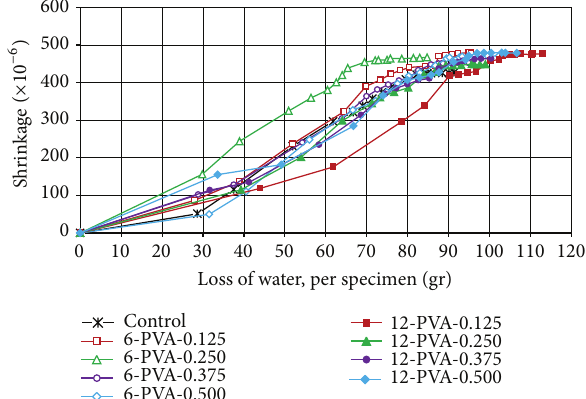
Figure 12: Relation between shrinkage and loss of water from